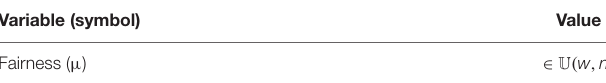
TABLE 3 | Fairness simulation variable. Variable (symbol) Value Fairness ( µ ) ∈ U ( w , n